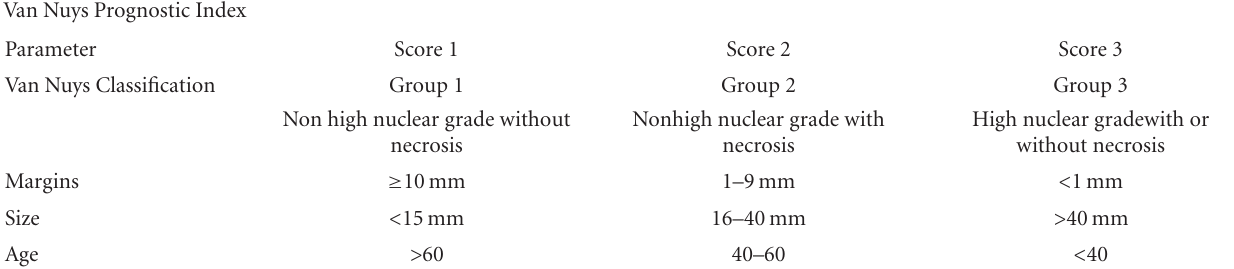
Table 1: The USC/VNPI scoring